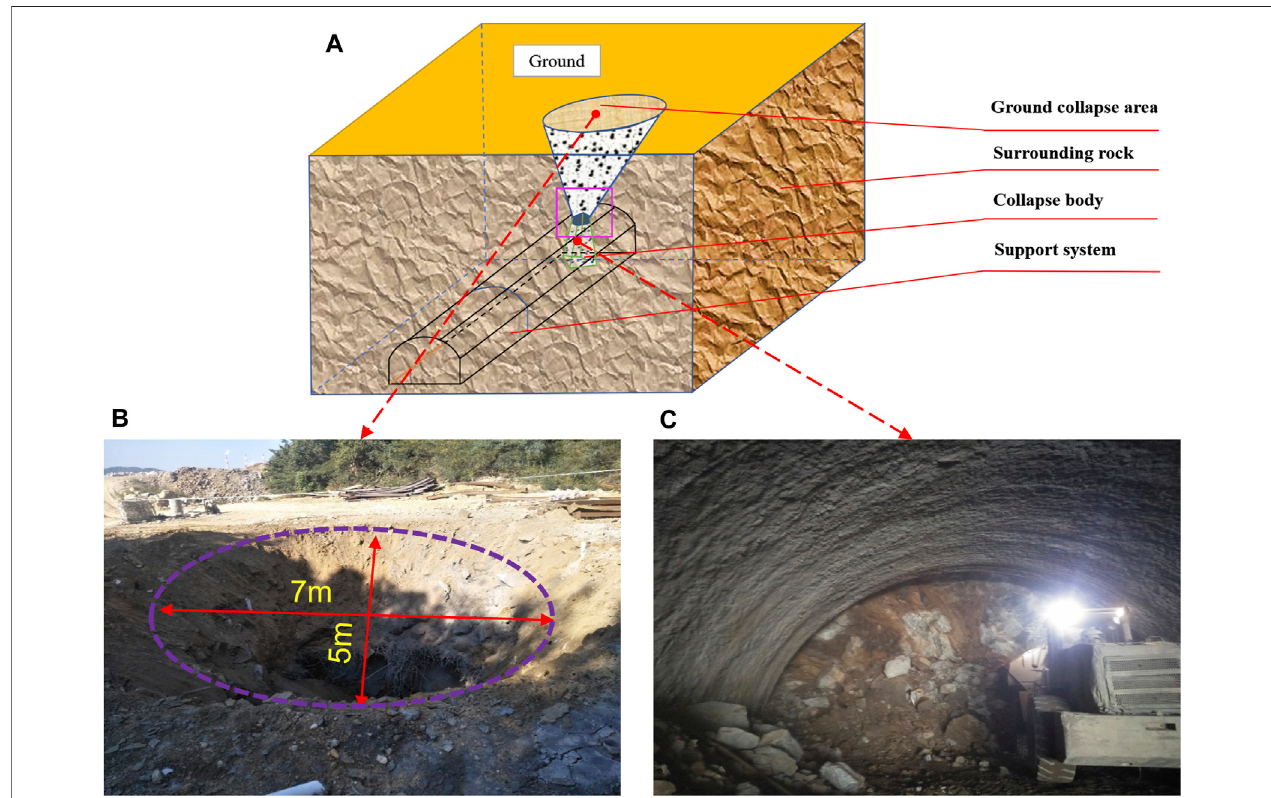
FIGURE2 | Collapse ofHuangjiakuangtunnels: (A) Schematic diagram oftunnel-shaped collapse at the Huangjiakuang right tunnel (Li et al., 2020b), (B) In fl uence range of collapse on the surface reaches 27.5 m 2 and (C) after the collapse, the construction machinery is dealing with the soil falling inside the tunnel.